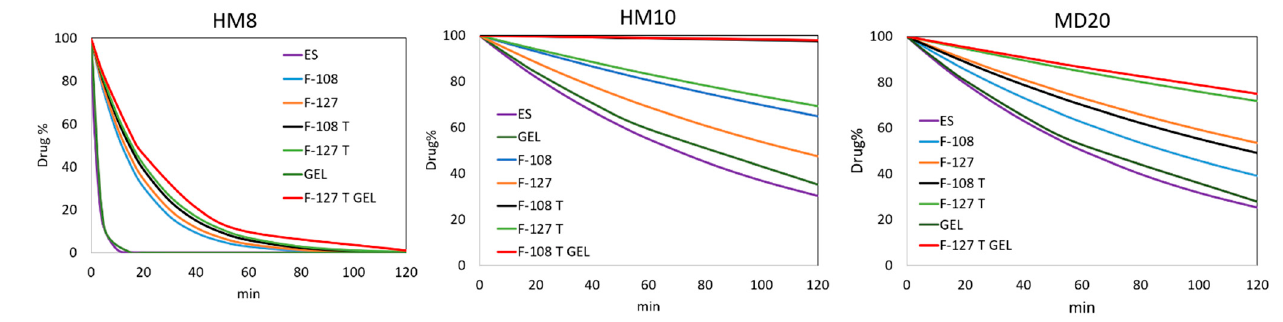
Figure 5. Photodegradation of HM8, HM10 and MD20 in ethanol, surfactant solutions and gel formulations. ES, ethanol solution; T, α -tocopherol.